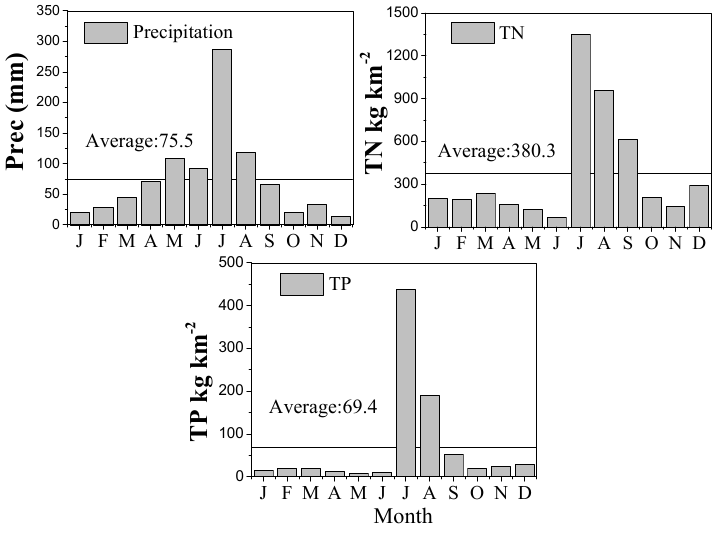
Figure 5. Average monthly total yields of TN and TP loads.